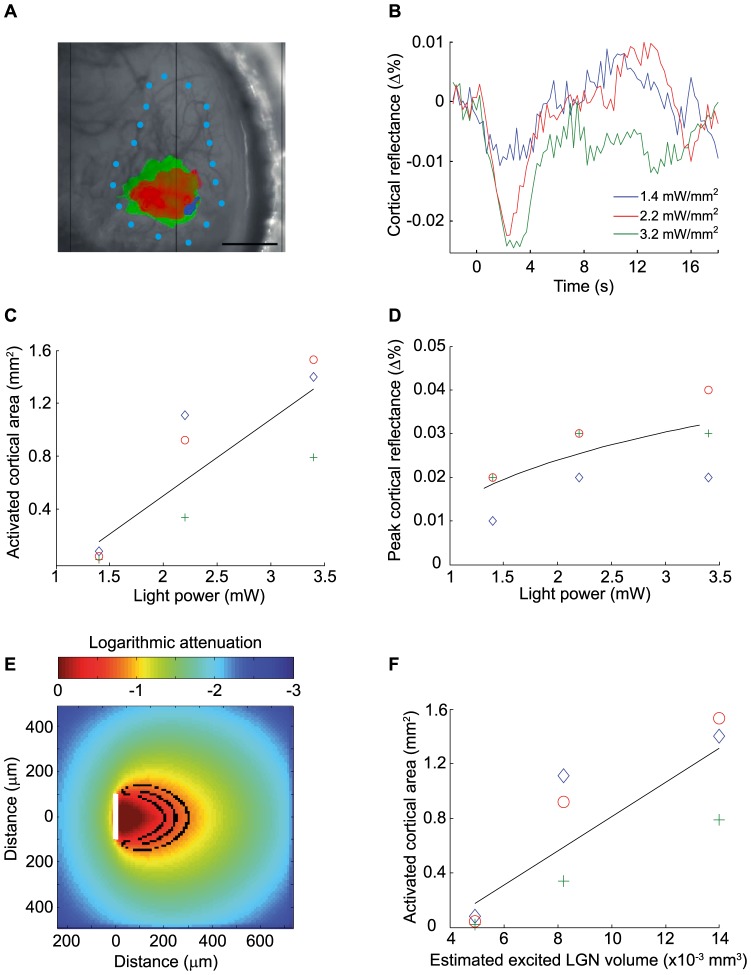
Effect of light power output on cortical activation in V1.
A. Anatomical image reference taken under a 545 nm illumination. Overlaid on the reference image are the activation maps obtained with different light intensities (green: 3.2 mW/mm2, red: 2.2 mW/mm2, blue: 1.4 mW/mm2). Maps were obtained by applying a t-stat threshold of p<0.01 (p<0.1 for 1.4 mW/mm2 due to lower signal to noise). Blue dots represent V1 delineation according to (Franklin and Paxinos, 2008). Scale bar: 1 mm B. Average time course of cortical reflectance from pixels included in the blue region illustrated in A, using the same light intensities as in A. C. Activated cortical area as a function of light intensity. Determination coefficient of the linear fit: 0.72, p<0.01, F-test, n = 3. D. Peak cortical reflectance as a function of light intensity. Determination coefficient of the logarithmic fit: 0.95, n = 3. E. Monte Carlo simulation of photon transport in the mouse thalamus for a 200 µm fiber with a numerical aperture of 0.37, using the same three light intensities. Concentric black ovals represent boundaries where neurons are illuminated by a fluence >0.5 mW/mm2, value at which ChR2 expressing neurons are at half-maximum firing rate (Wang, H., 2007). From smallest to largest: 1.4 mW/mm2, 2.2 mW/mm2 and 3.2 mW/mm2. White bar indicates diameter of the fiber, from which photons are emitted. F. Activated cortical area as a function of estimated LGN volumes excited. Determination coefficient of the linear fit: 0.71, p<0.01 F-test, n = 3. Note the similar distribution with C.